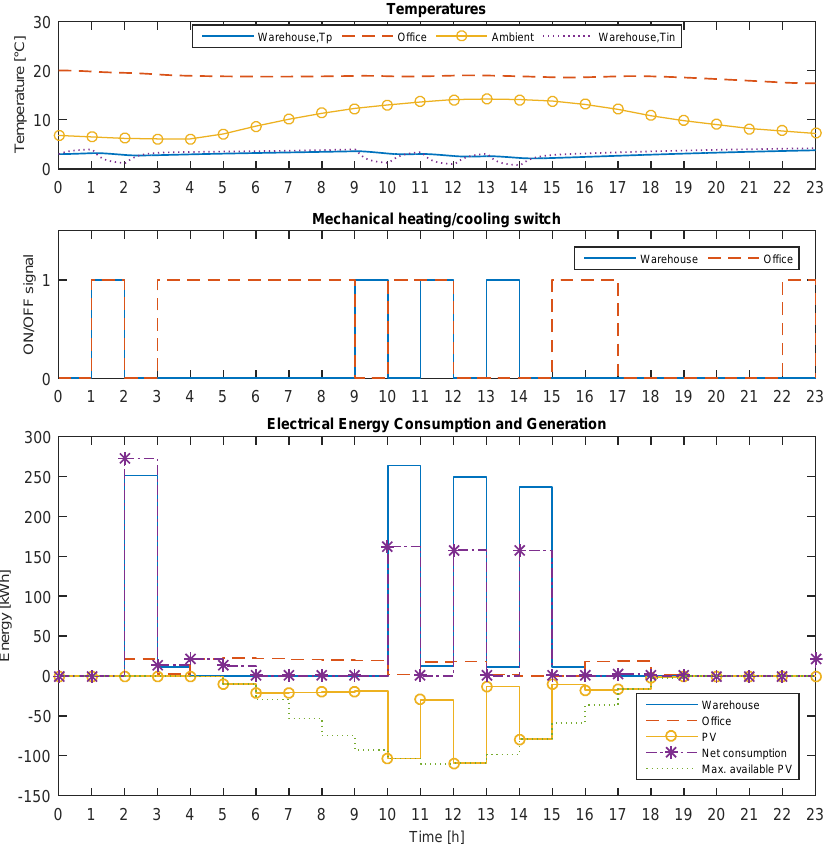
Figure 6. Energy minimization results for the average temperature scenario.